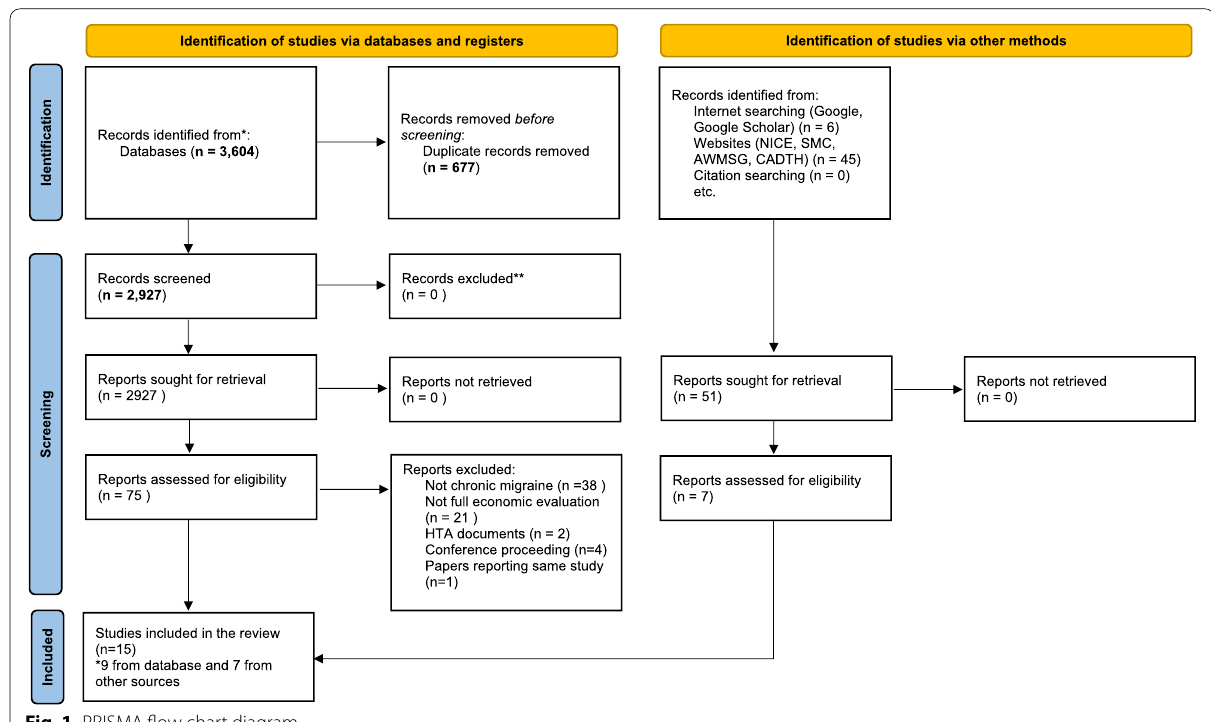
Fig. 1 PRISMA flow chart